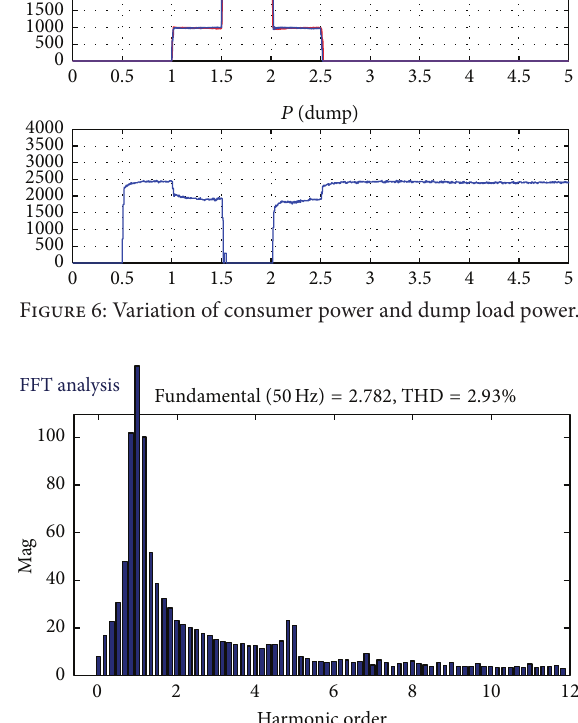
Figure 7: FFT analysis of load current at full load.